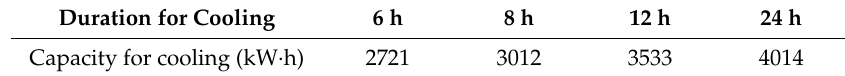
Table 3. Total capacity of the embedded tubes for cooling during the cooling period with various durations for cooling.